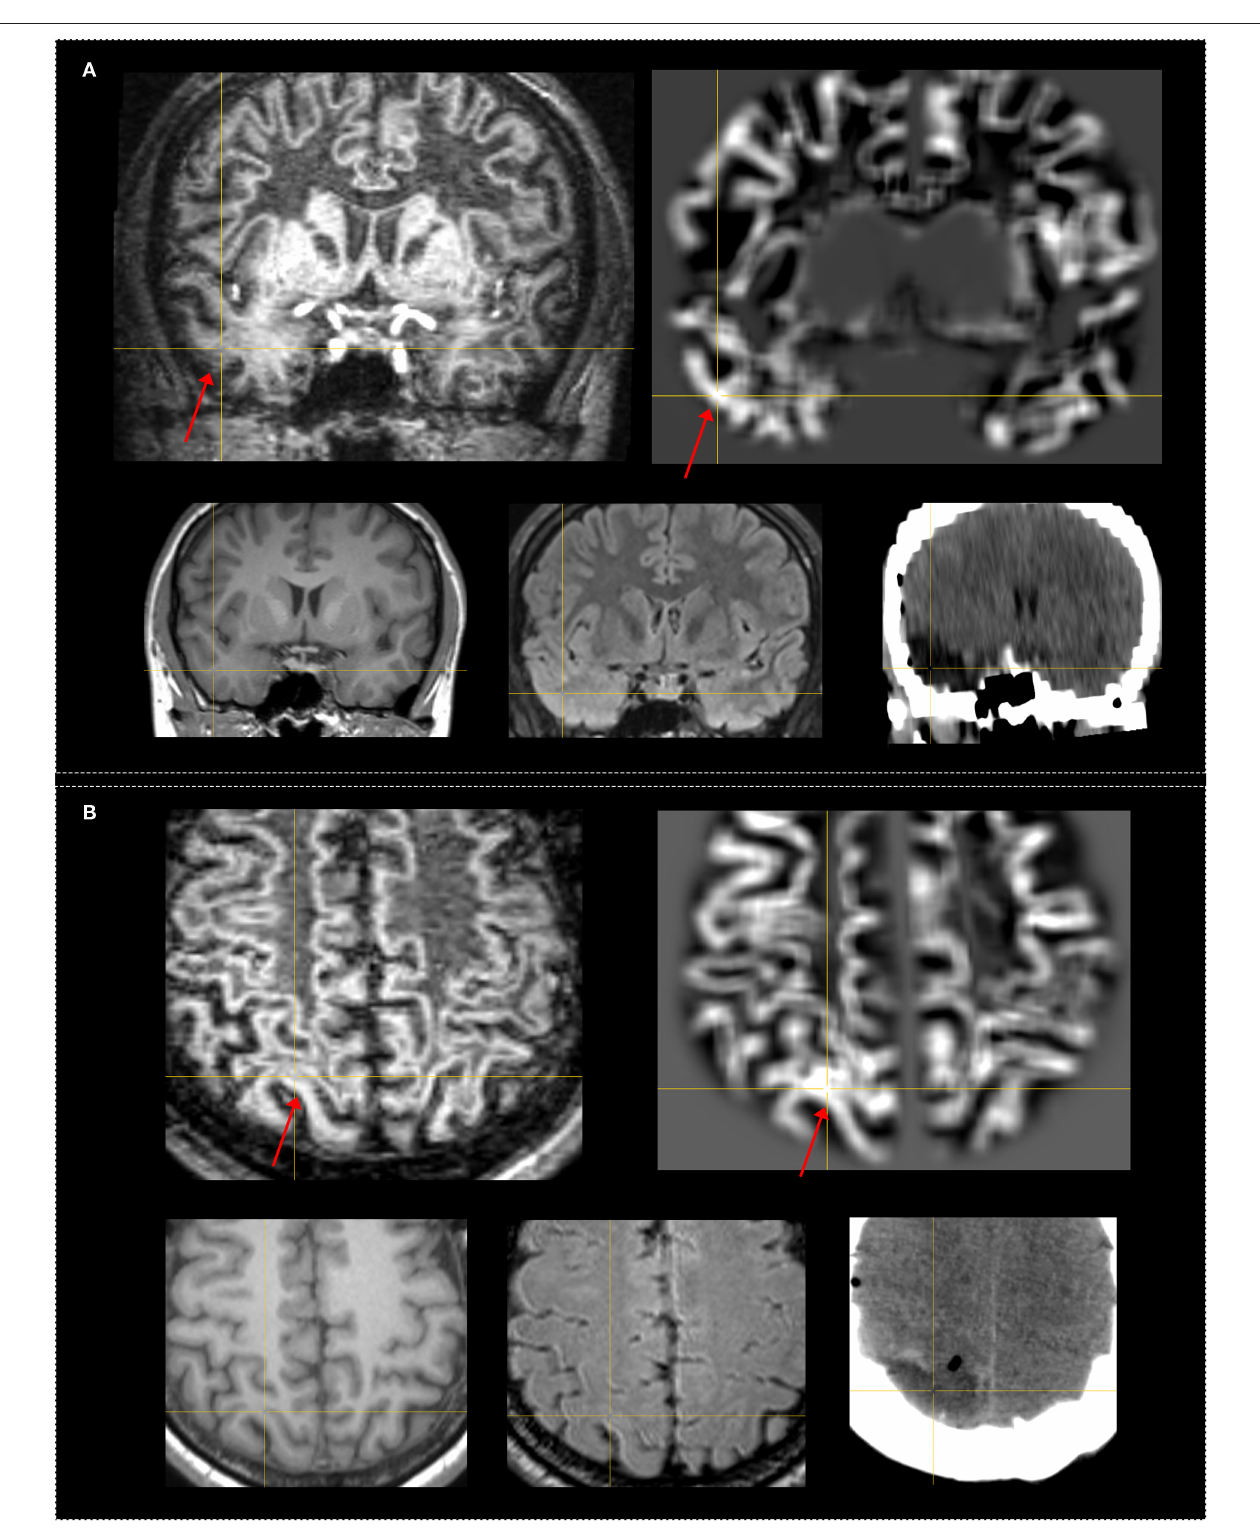
FIGURE 4 | Examples of patients who had subtle FLAWS + region revealed only under the guidance of the MAP + region. Both patients were seizure-free after surgery. The FLAWS + and MAP + region was concordance with resection. The crosshairs indicate the same coordinate between different images. The red